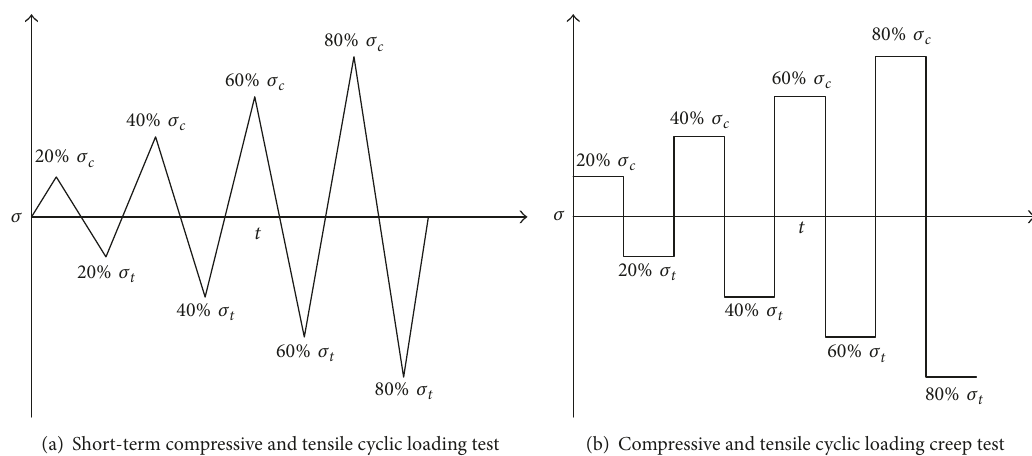
Figure 5: The sketch of incremental compressive and tensile cyclic loading.